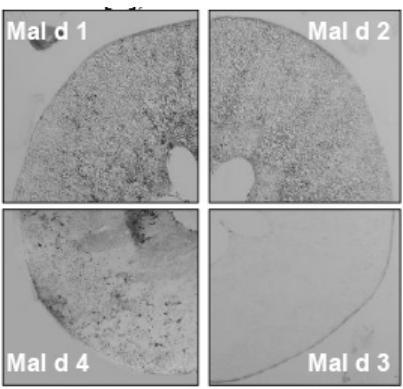
Figure 3. Immuno-tissue prints allowed the localization of the four major apple allergens within the apple tissue (adapted from